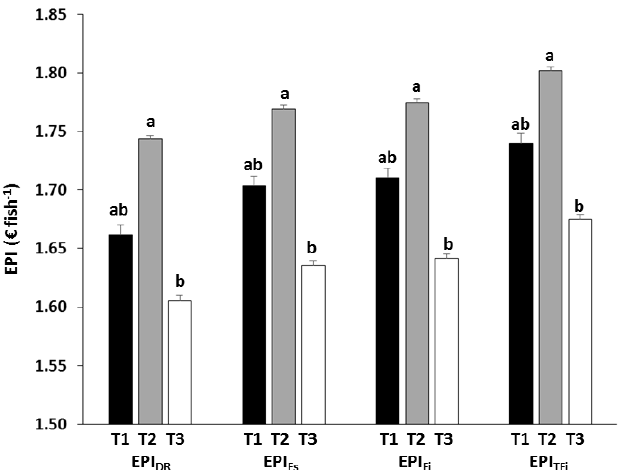
Figure 10. Overall values (mean ± standard error) of the different economic profit index (EPI). Different letters over the columns indicate significant differences (Tukey HSD , P < 0.05) between feeding treatments.